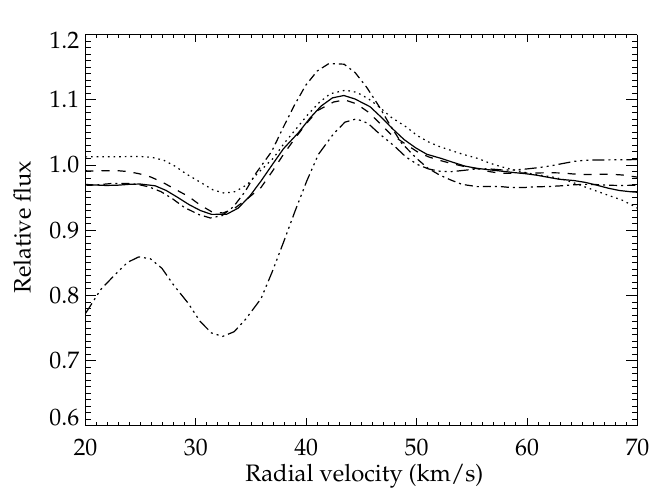
Fig. 8. The Ti I emission lines at 8766.68, 8734.71, 8692.329, 8682.98, 8675.37 ˚ A in the spectrum of R Sct observed on JD = 2454621.6 (the NARVAL database).